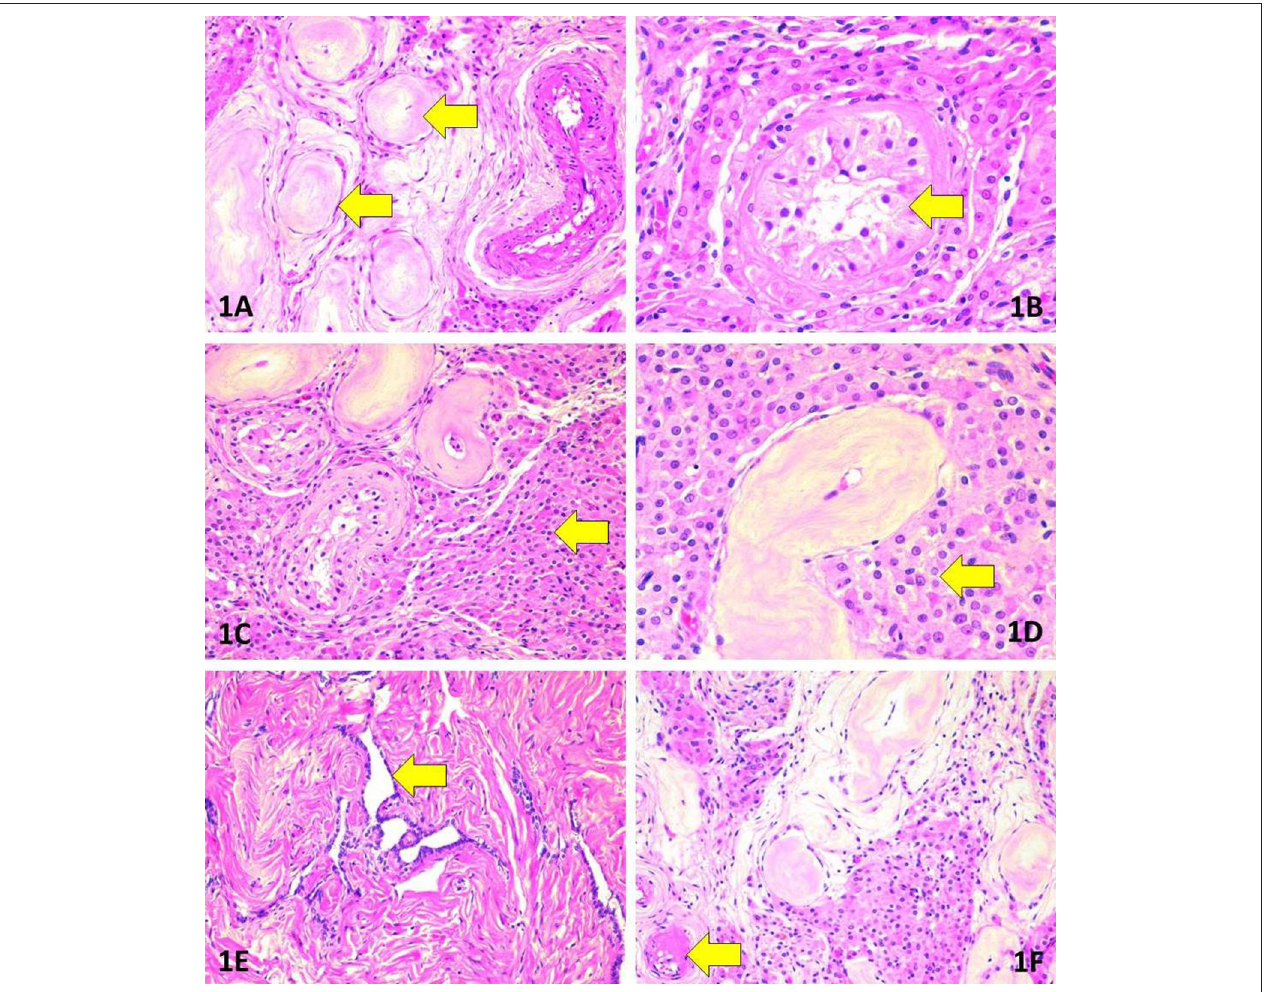
FIGURE 2 | Morphologic findings in surgically removed testes. (A) Marked tubular atrophy. Note the thickening and hyalinisation of the basement membrane as well as complete loss of tubular cells (arrows). Haematoxylin-eosin (HE), original magnification (OM) 200x. (B) Absence of spermatogenesis (arrow). Note also the nuclear features justifying the absence of germ cell neoplasia in situ . HE, OM 400x. (C) Extensive hyperplasia of Leydig cells (arrow) adjacent to atrophic tubules. HE, OM 200x. (D) Morphology of Leydig cells (arrow). Note the absence of Reinke’s crystalloids. HE, OM 400x. (E) Rete testis. HE, OM 200x. (F) Hyalinisation in an arteriole (arrow). HE, OM